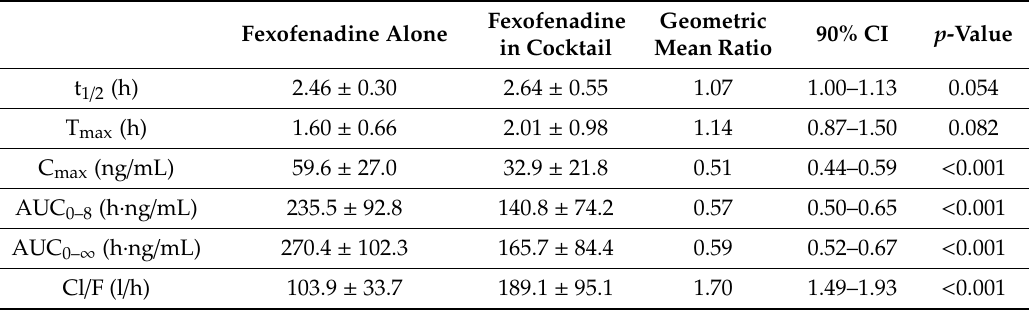
Table 2. Pharmacokinetic parameters of fexofenadine administered alone or with cytochromes (CYP) probe substrates.